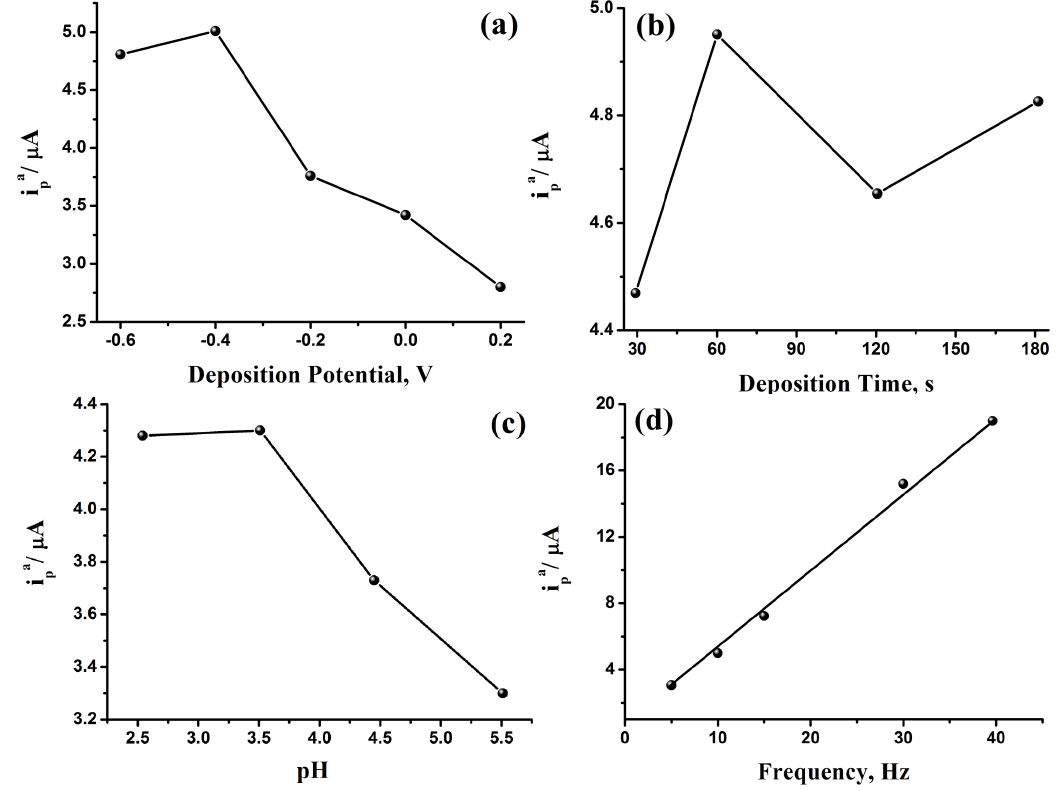
Figure 4. Effect of accumulation potential ( a ), accumulation time ( b ), and pH ( c ) on the anodic peak current of 3.22 × 10 − 5 M FA on PPy-MWCNTs/GCE in 0.2 M H 3 PO 4 (pH 2.54) at a frequency of 10 Hz and square wave frequency ( d